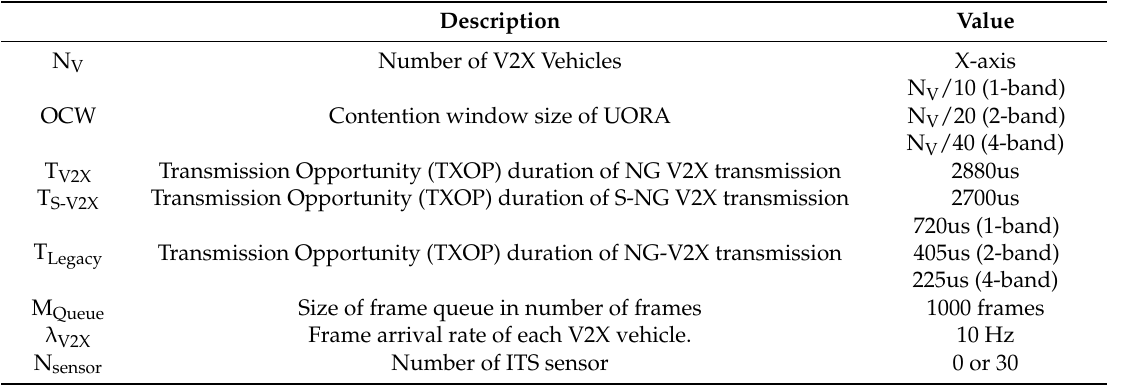
Table 1. Simulation parameters.